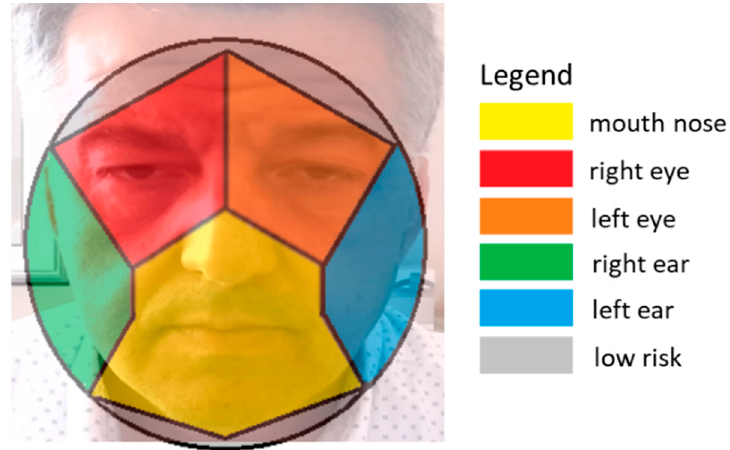
Figure 5. A schematic of the contact areas onto the sphere modeling the head corresponding to the six contact event classes detected by the HealthSHIELD event classifier.